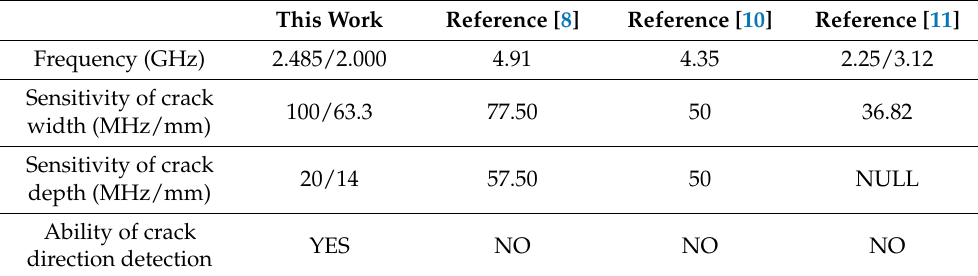
Table 3. Comparison of different kinds of metal crack detection